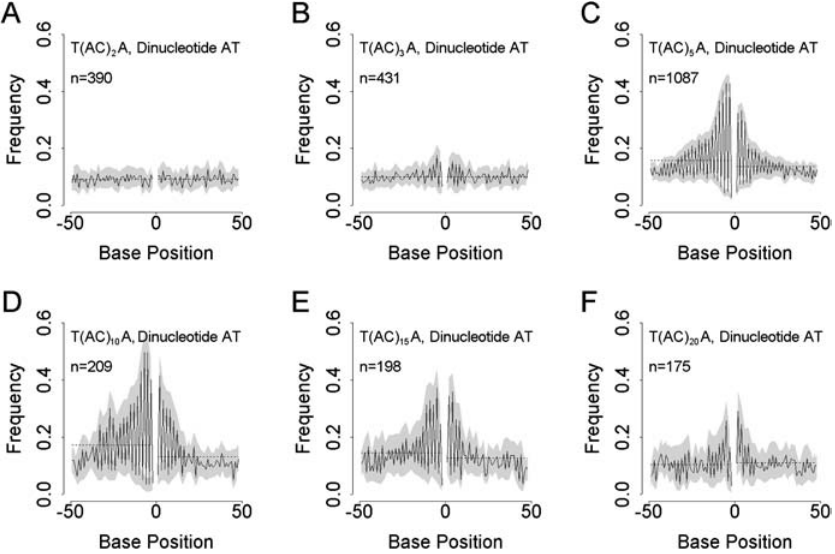
Figure 5. Dependence of Dinucleotide Flanking Sequence Patterning on AC Re- peat Number Plots are as described in Figure 4. The progression for dinucleotide AT is illus- trated for the commonest cassette type, (T/A). (A–F) depict AT dinucleotide frequencies, where patterning is most extreme, and show how periodicity and amplitude increase towards a maximum at around (AC) 10 and decline